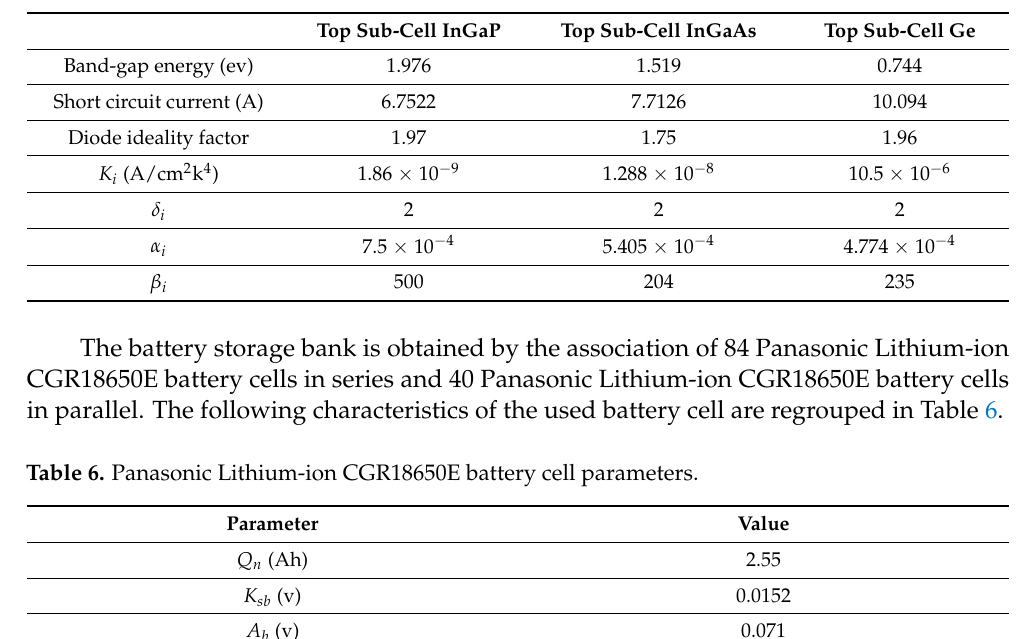
Table 5. Triple-junction InGap/InGaAs/Ge solar cell parameters.